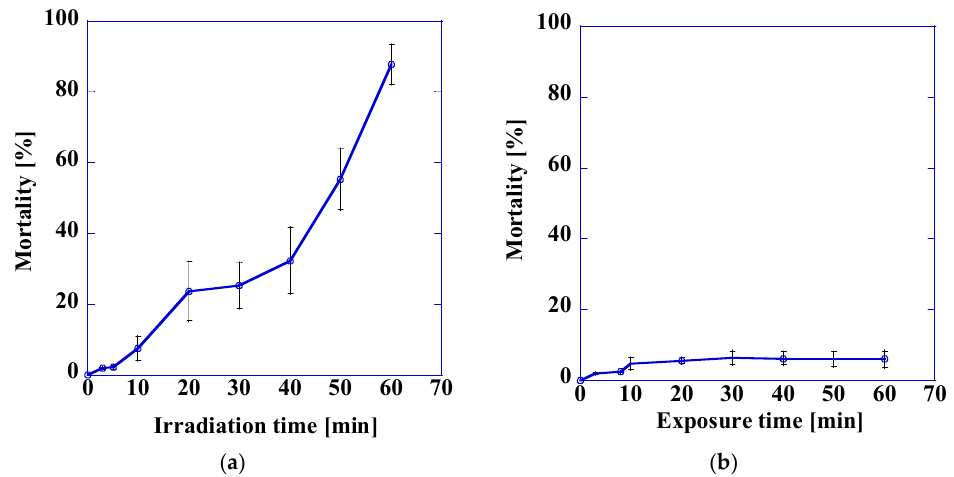
Figure 6. Variation in mortality due to ozone and UVC irradiation. ( a ) Change in mortality as a function of UV exposure time. The mortality showed low efficacy during the first 10 min of irradiation but then increased, culminating in a mortality of 88% after 60 min of exposure to UV radiation at a wavelength of 253.7 nm. Error bars indicate standard deviation. ( b ) Change in mortality as a function of ozone exposure time. The mortality did not increase with longer exposure to ozone. The concentration was 10 ppm. Error bars indicate standard deviation.